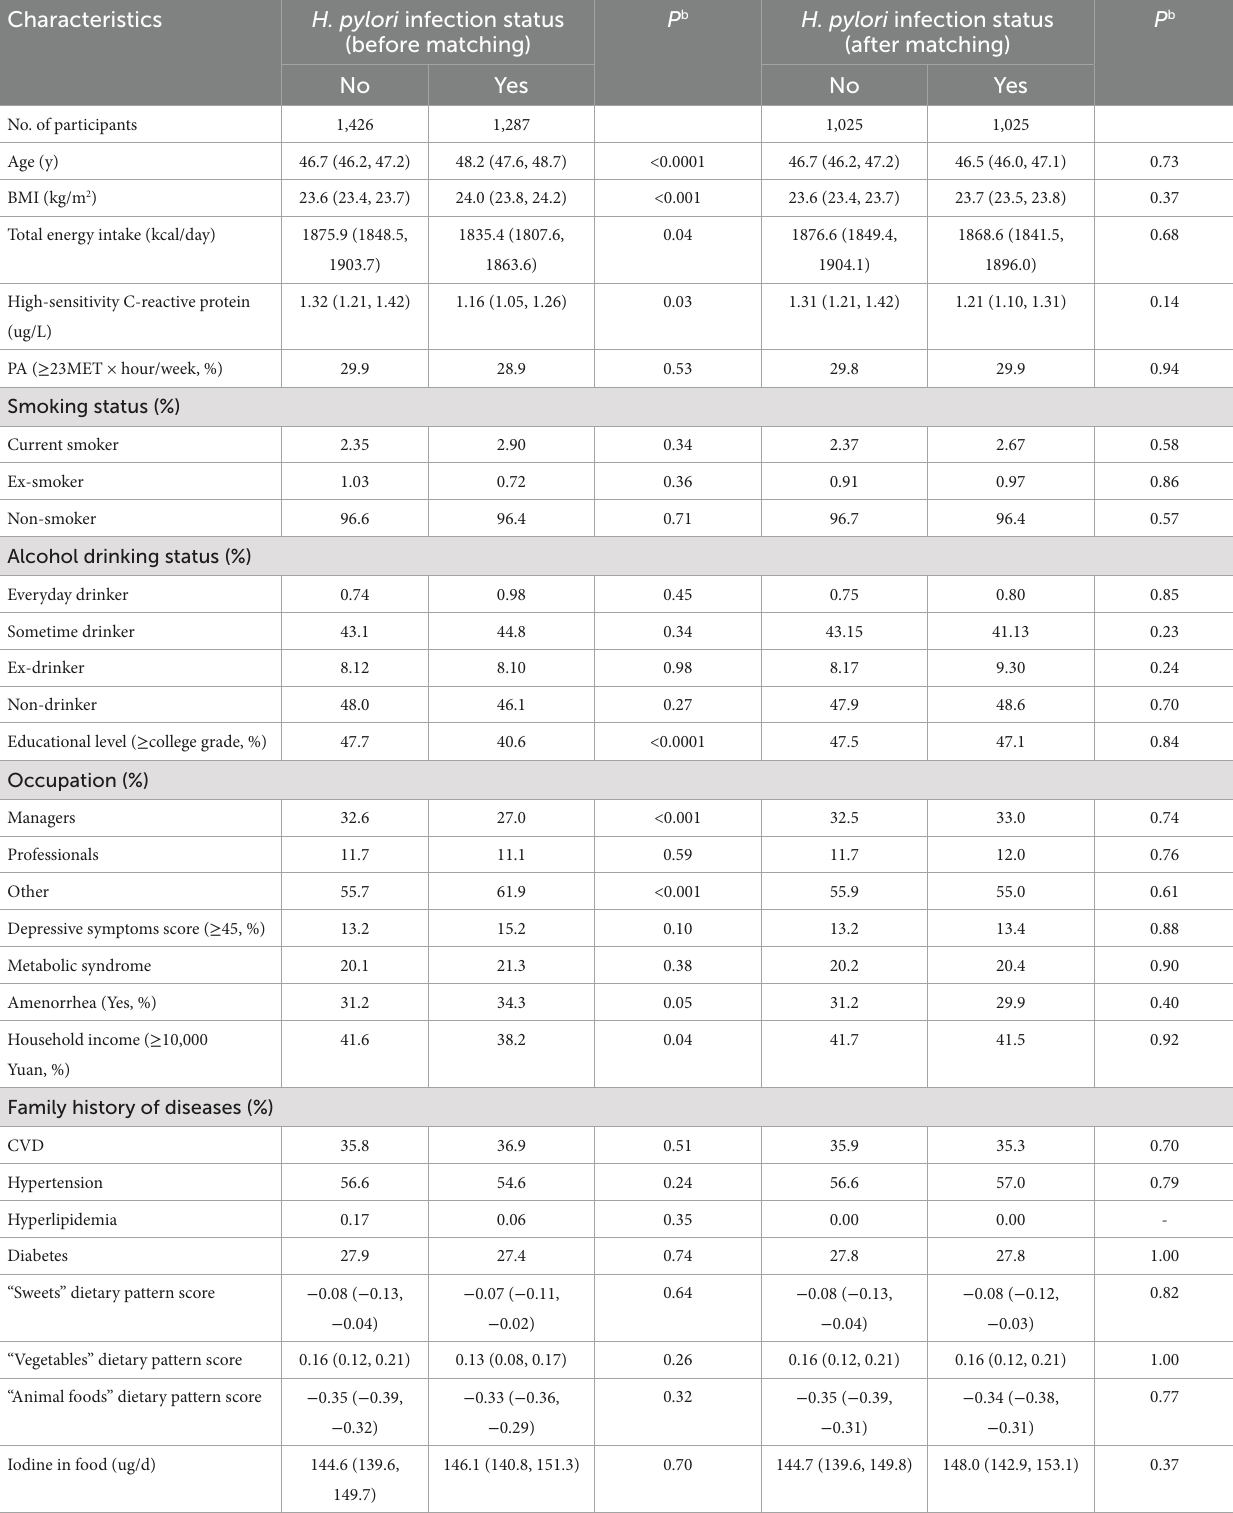
TABLE 1 Characteristics of the participants according to Helicobacter pylori infection status before and after matching in women. a